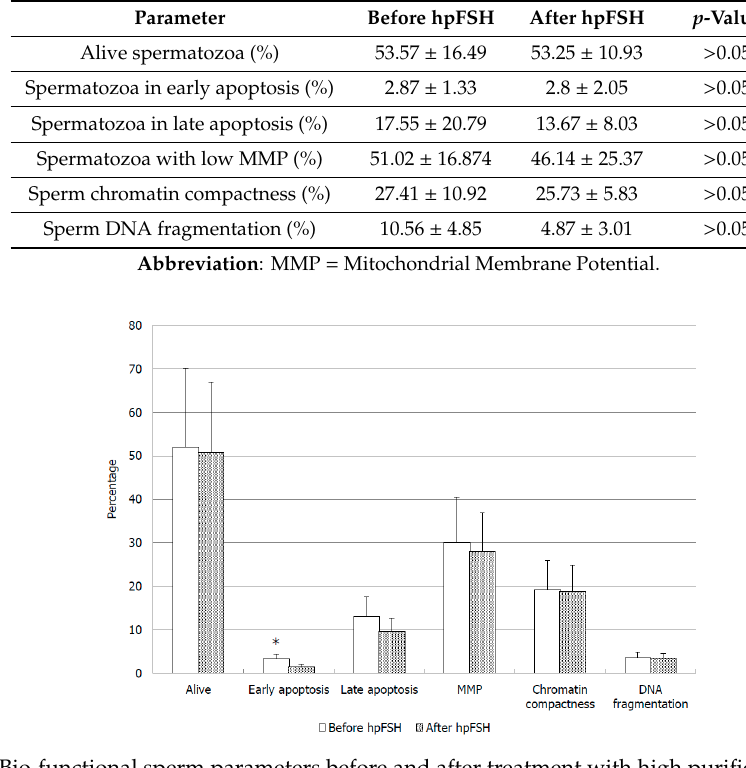
Figure 2. Bio-functional sperm parameters before and after treatment with high purified FSH (hpFSH) in infertile non ‐ responder patients. * p < 0.05